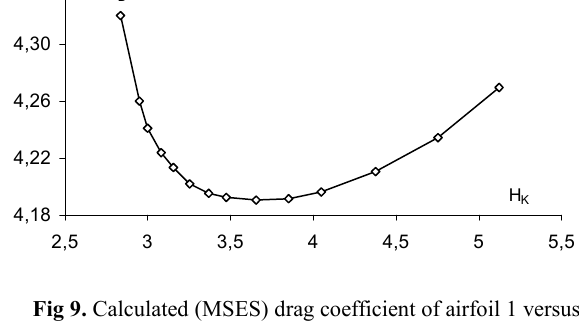
Fig 9. Calculated (MSES) drag coefficient of airfoil 1 versus shape parameter H K at the transition on the up-per side versus forced transition location at a = -1.5 ° 10 3 xC D